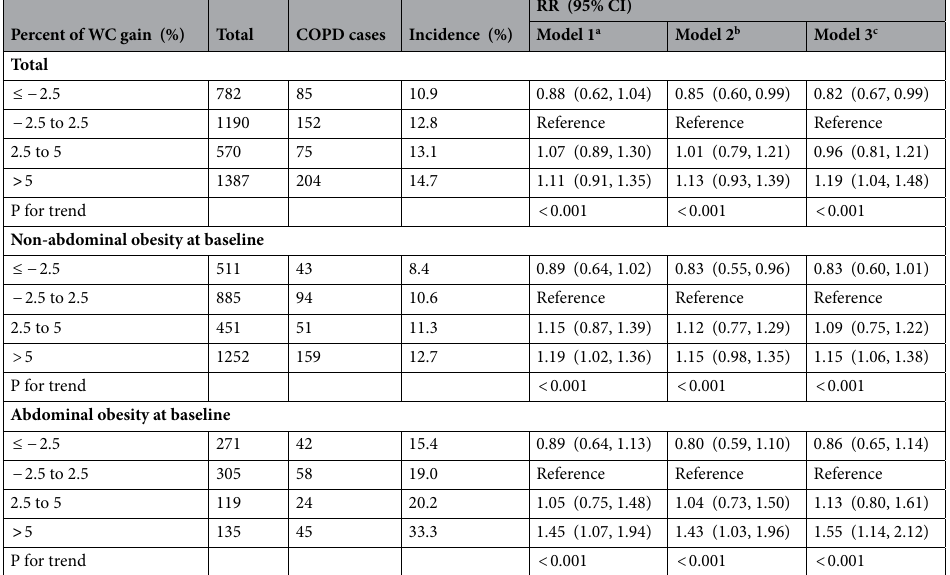
Table 2. Risk of chronic obstructive pulmonary disease (COPD) by percentage of waist circumference (WC) change for men. Data are relative risk (RR) and 95%CIs. a Adjusted for age at baseline. b Adjusted for variables in model 1 as well as education level, smoking status, alcohol drinking, and physical activity at baseline. c Adjusted for variables in model 2 as well as body mass index, systolic blood pressure, diastolic blood pressure, fasting plasma glucose, total cholesterol, triglycerides, high density lipoprotein cholesterol, forced expiratory volume in one second and forced vital capacity at baseline.